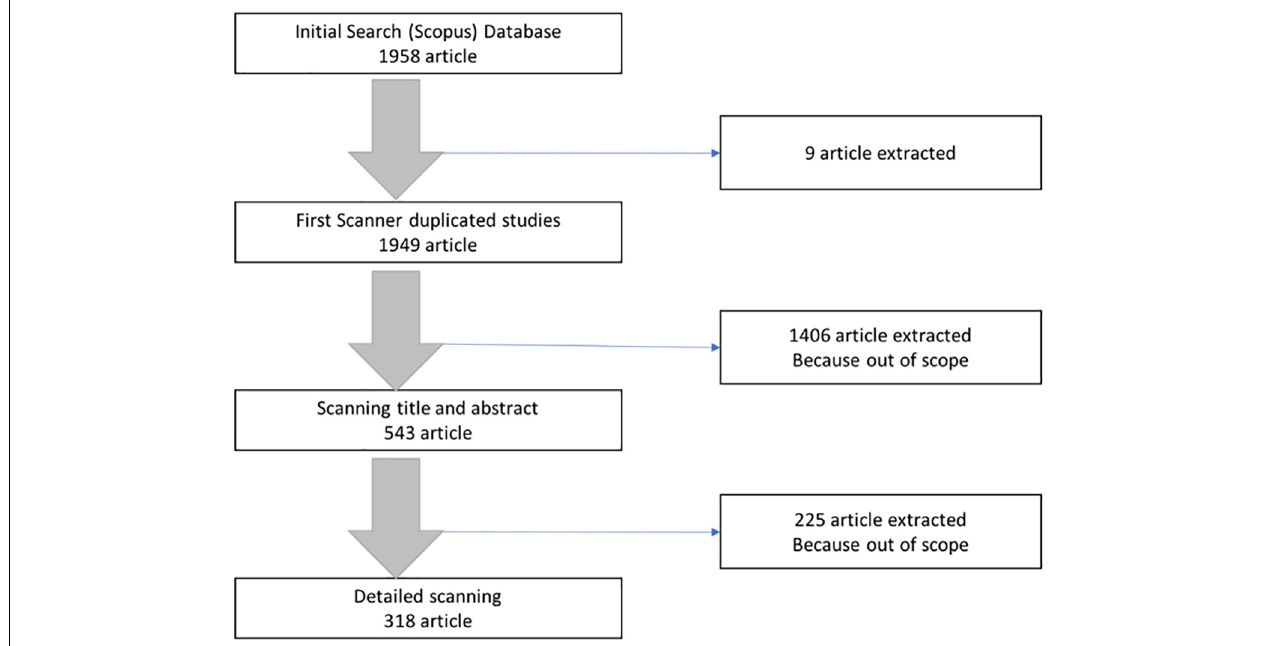
FIGURE 1 | Flowchart on data